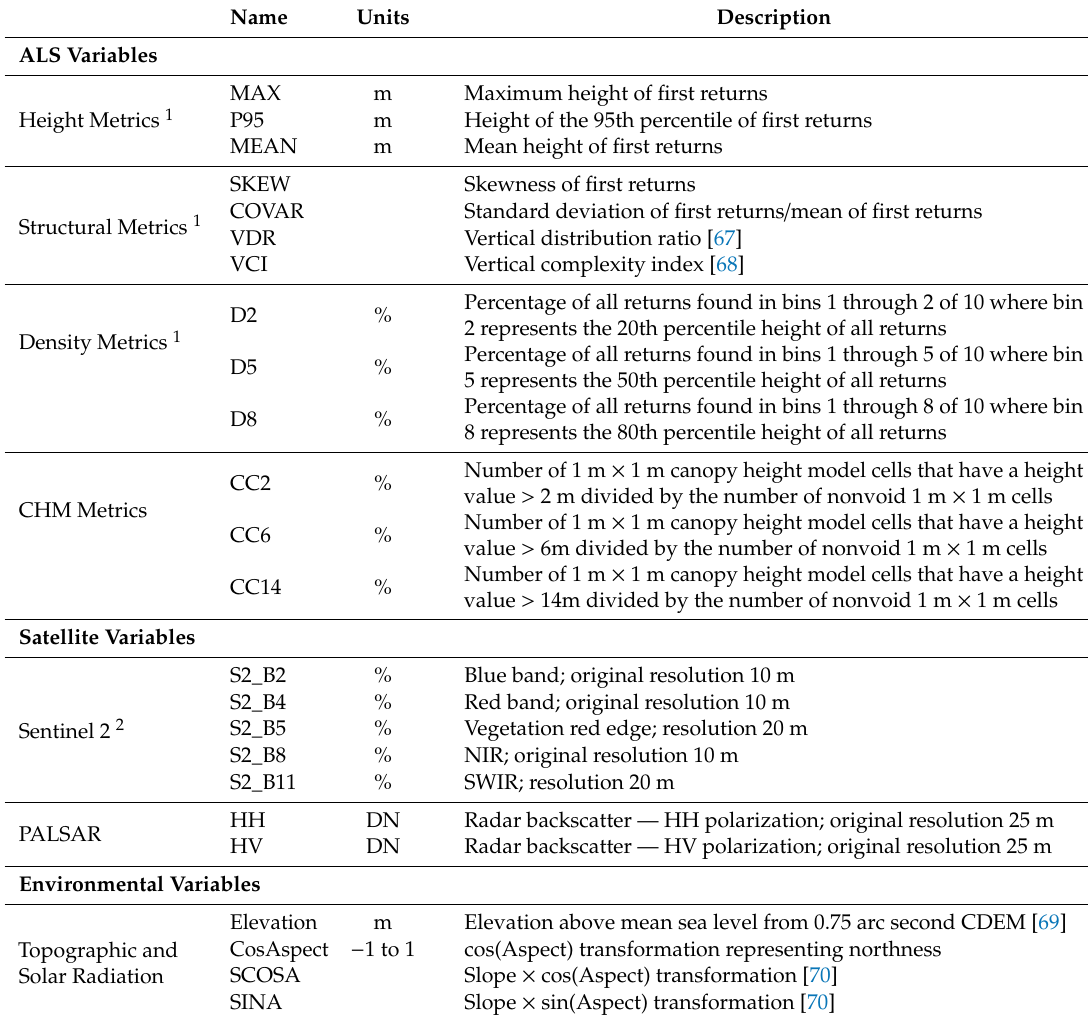
Table 2. Description of airborne laser scanner (ALS), satellite and environment data used as predictor